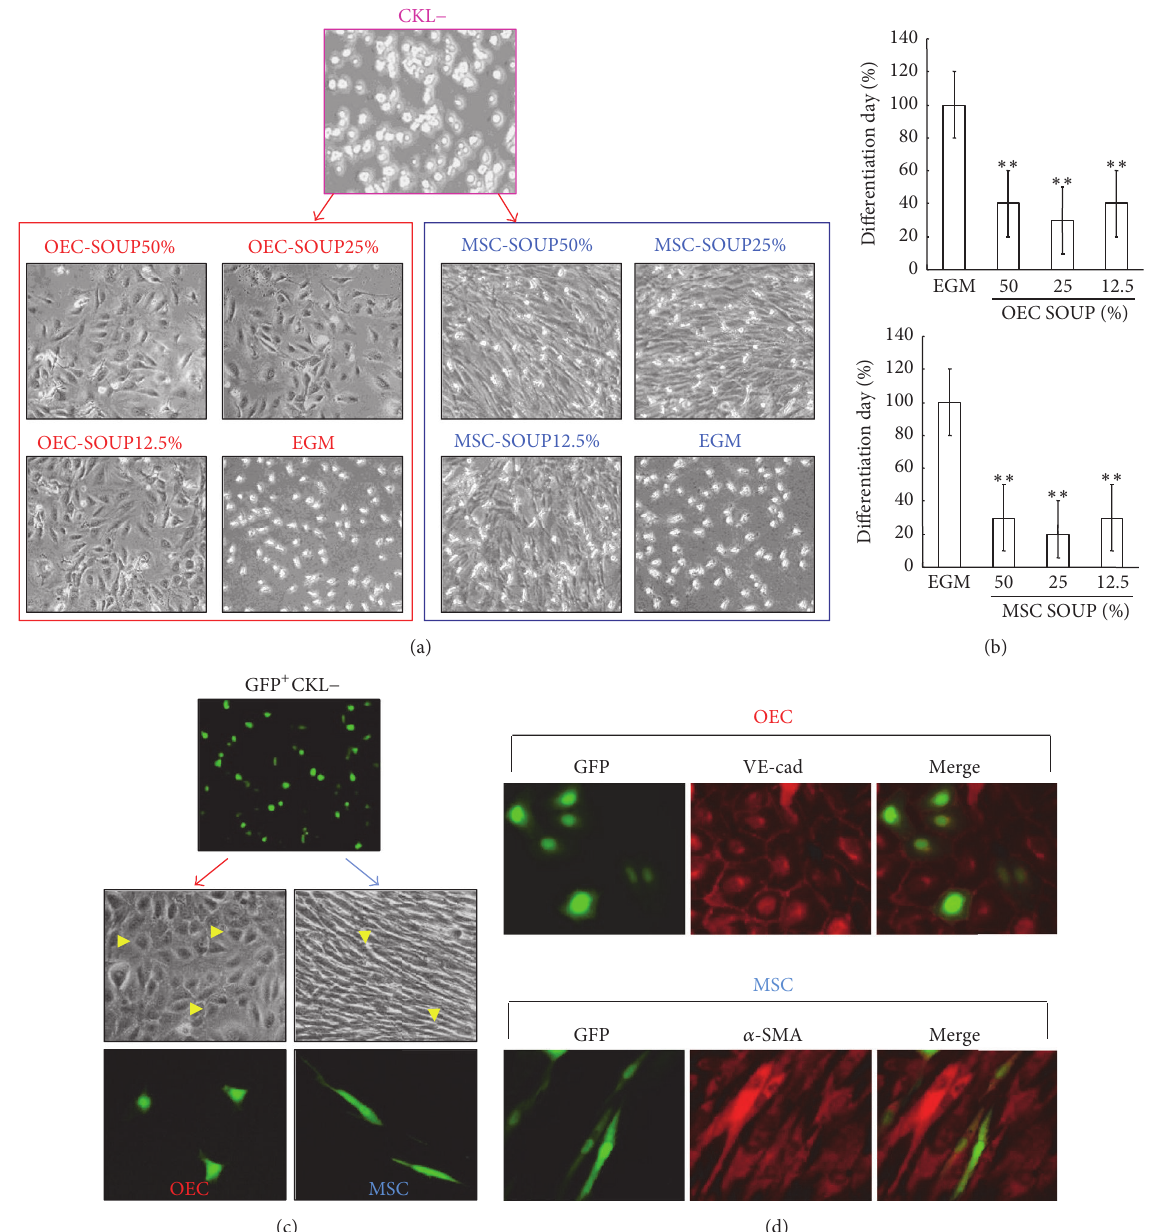
Figure 3: Soluble factors generated from OECs or MSCs accelerate CKL − cell differentiation. (a) CKL − cells were cultured in OEC- or MSC-conditioned medium in a dose-dependent manner (0, 12.5, 25, or 50%). (b) The day of differentiation, defined as the first day on which differentiated colonies were observed from the time of seeding, occurred significantly sooner in CKL − cells differentiated in conditioned mediumcomparedwithcontrolconditions. ∗∗ 𝑝 < 0.01 versuscontrol.(c)GFP+CKL − cellswerecoculturedwithOECsorMSCs.Arrowheads indicate morphologically differentiated GFP + OECs or MSCs. (d) OECs or MSCs differentiated from GFP + CKL − cells were characterized by immunofluorescent staining using VE-cad or 𝛼 -SMA antibody,